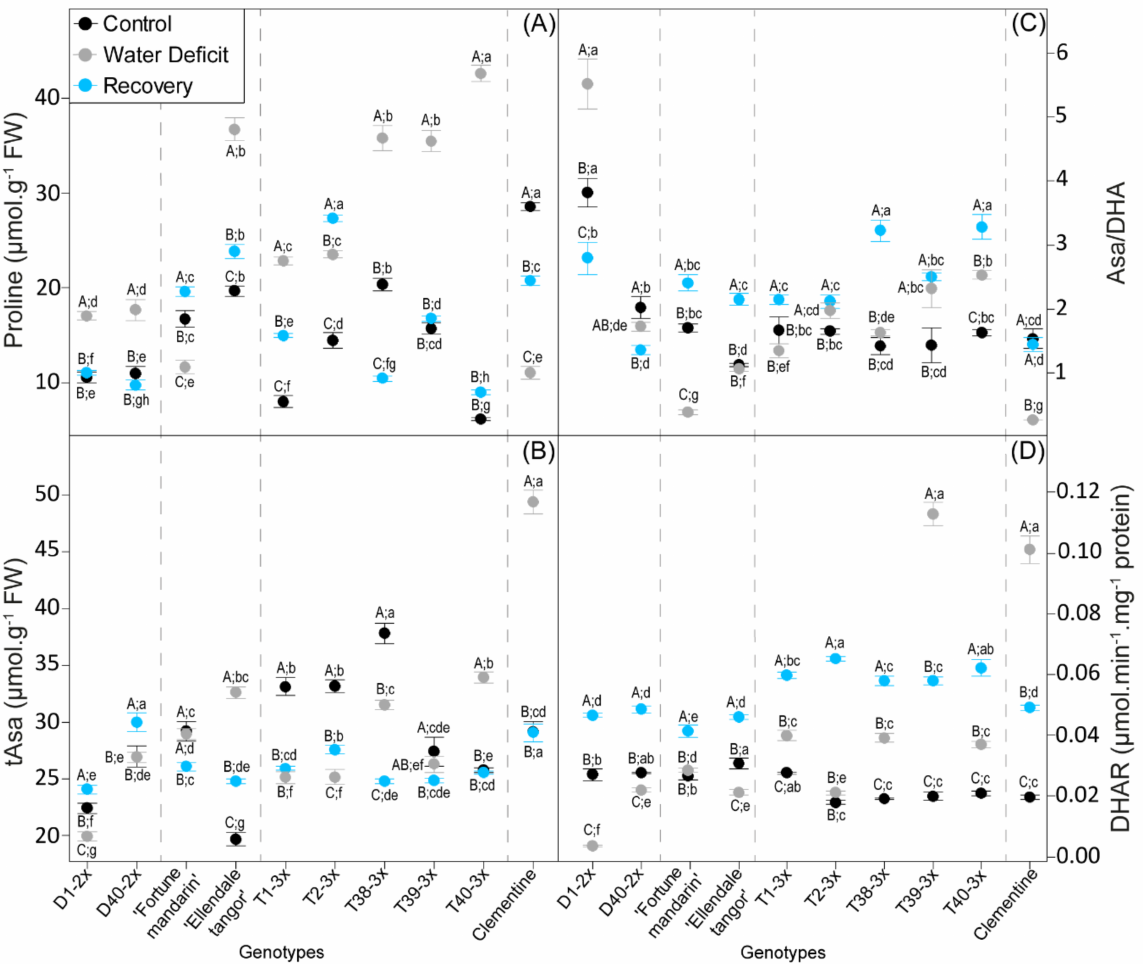
Figure 4. Changes in ( A ) proline, ( B ) tAsa content, ( C ) Asa/DHA ratio, and ( D ) specific activity of dehydroascorbate reductase (DHAR) in 2x and 3x genotypes under three water treatments: 70–100% pot capacity (black point, control), 45–55% pot capacity (grey points, water deficit), and five days after re-watering (blue point, recovery). All data are mean values ( ± S.E.) of 15 independent measurements ( n = 15). Data were analyzed with ANOVA and Fisher’s LSD test ( p < 0.05). Uppercase letters compare water treatments for each genotype. Lowercase letters compare genotype within the same water